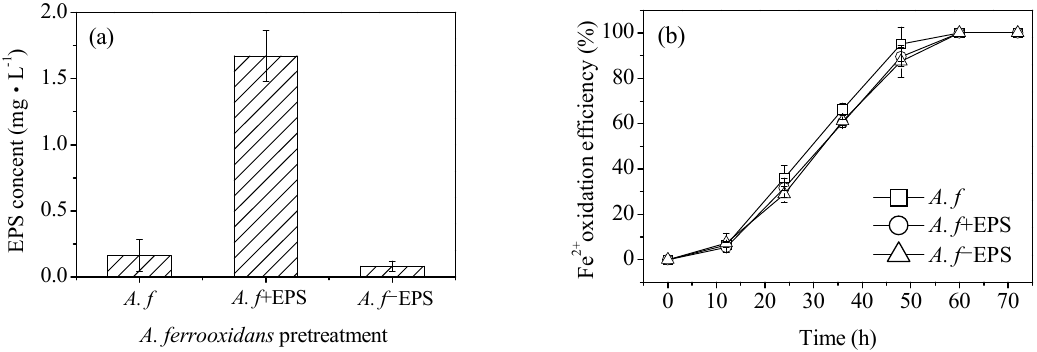
Figure 5. Comparison of ( a ) EPS content in supernatant and ( b ) Fe 2+ oxidation efficiency under different treatment at 28 °C and 180 rpm for 72 h: A. f , conventional A. ferrooxidans ; A. f +EPS, A. ferrooxidans with EPS exfoliated but not removed; A. f −EPS, A. ferrooxidans with EPS exfoliated and removed. Experimental conditions: initial pH = 3.0; FeSO 4 ·7H 2 O dosage 11.12 g; A. ferrooxidans density 6.0 × 10 6 cell·mL −1 .